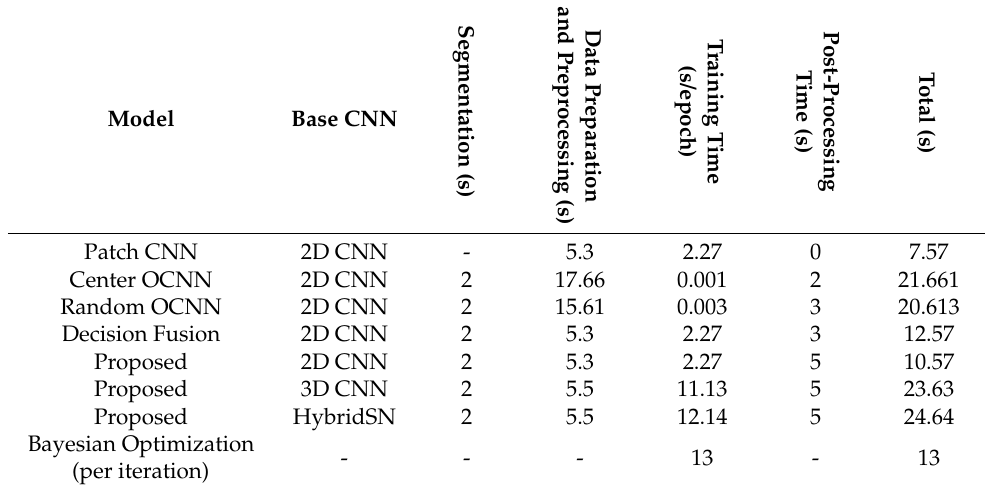
Table 8. The computational efficiency of the proposed and benchmark classification models including their